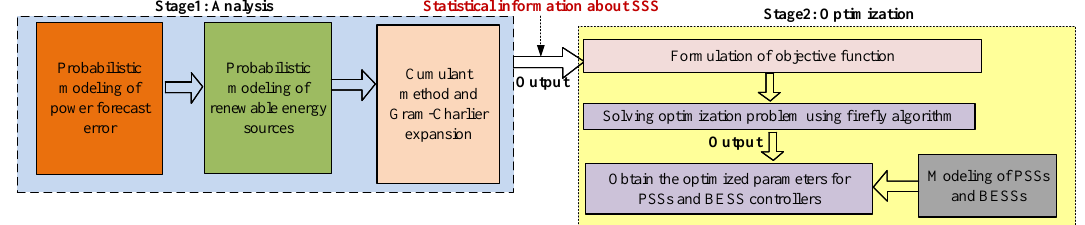
Figure 1. Proposed method to coordinate power-system-stabilizer (PSS) and battery energy-storage- system (BESS) controllers under renewable-energy-source (RES)